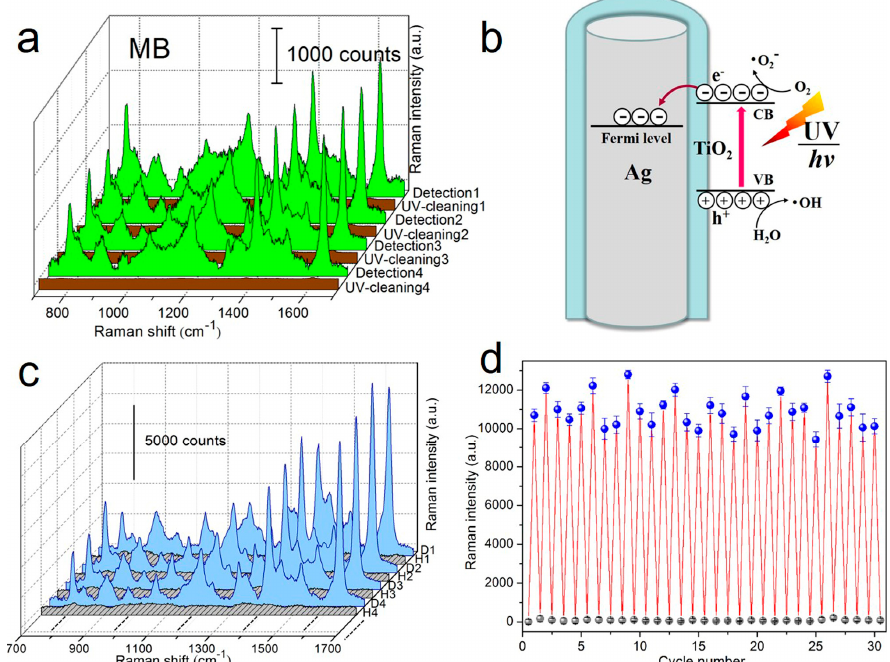
Figure 6. ( a ) Raman spectra of 5 × 10 − 6 M MB molecules adsorbed on the AgNRs substrate coated with ~2 nm TiO 2 in four “detection-UV cleaning” cycles; ( b ) the schematic for the photocatalytic mechanism of AgNRs-TiO 2 hybrids (Reprinted with permission from [57]); ( c ) Raman spectra of 1 × 10 − 6 M MB